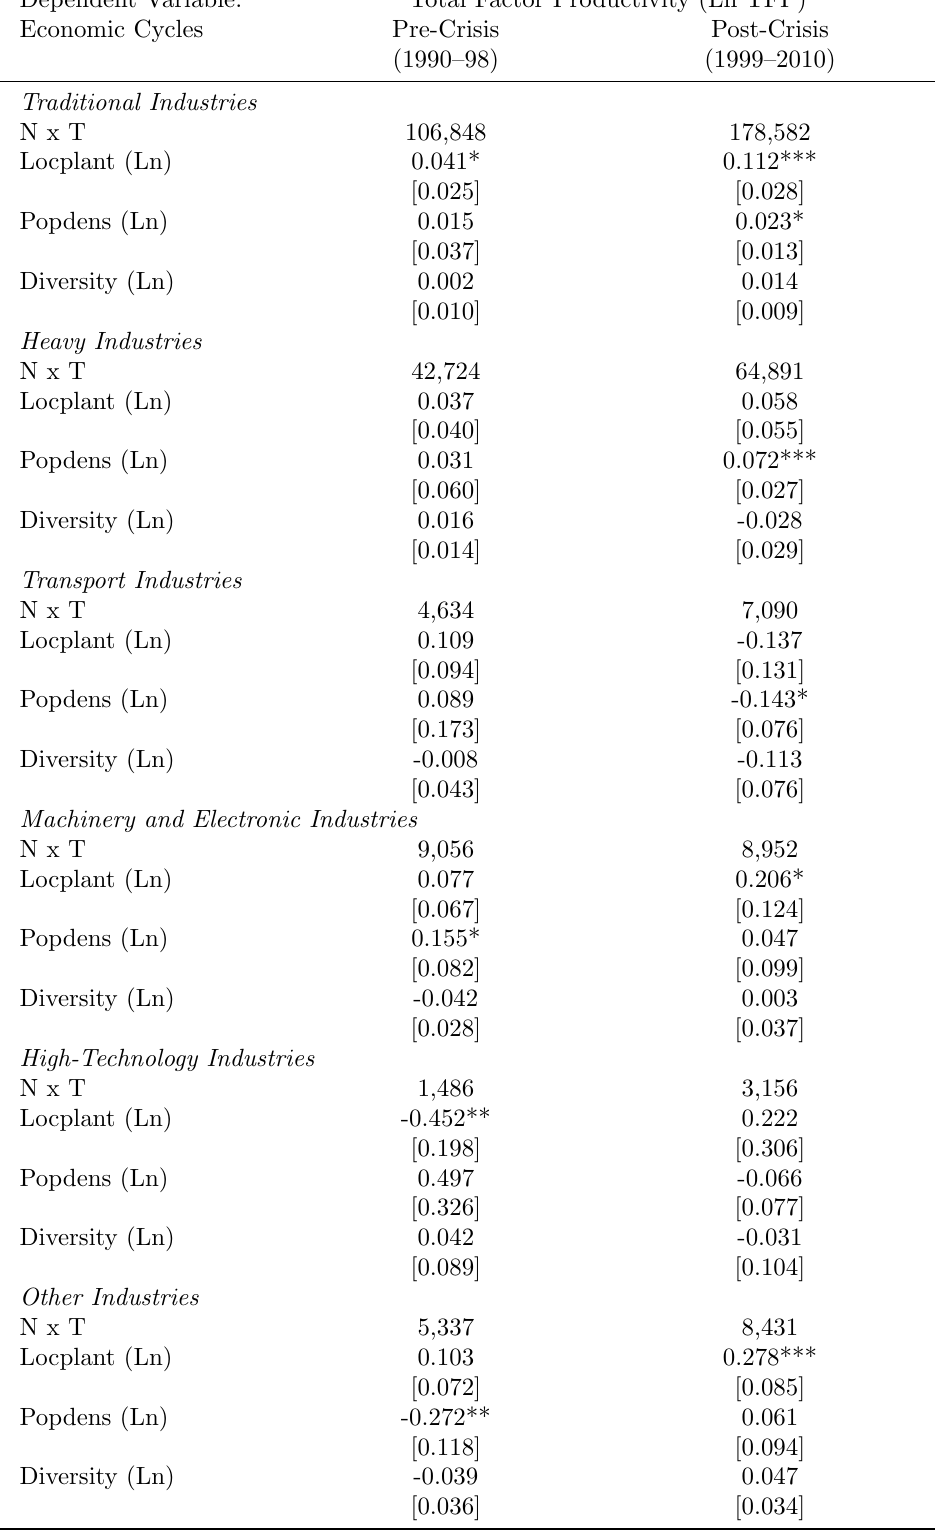
Table 4: Agglomeration Externalities by Industry over Economic Cycles Dependent